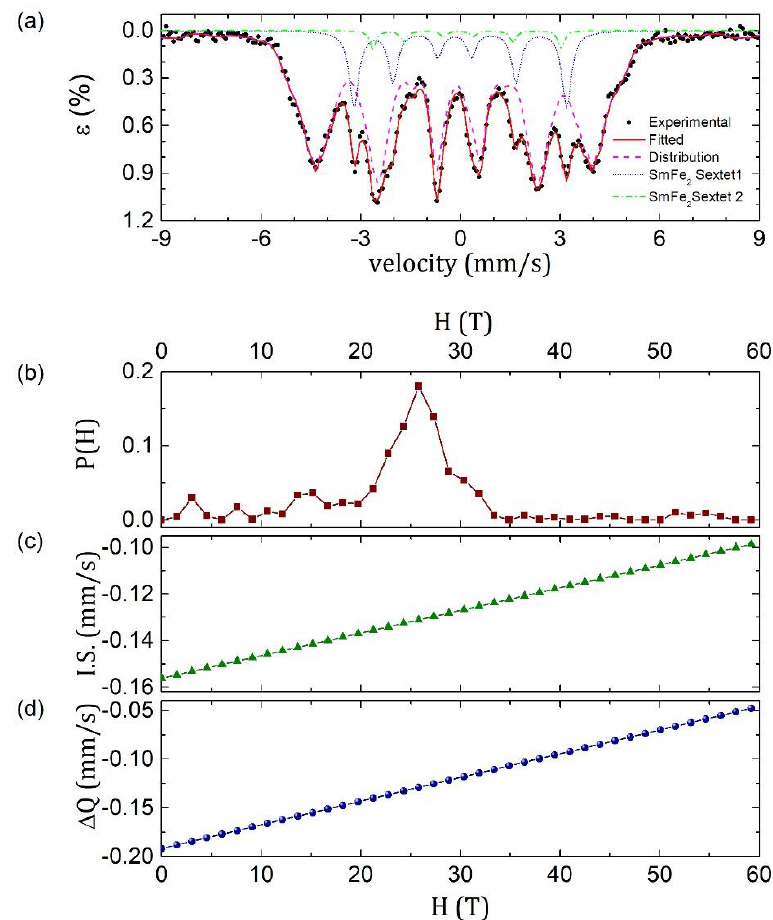
Figure 4. ( a ) Mössbauer spectrum collected and fitted to an amorphous phase and to SmFe 2 phase, ( b ) distribution function of effective magnetic fields for the amorphous phase, ( c ) isomer shift linear function for the amorphous phase, and ( d ) quadrupolar splitting linear function for the amorphous phase. Table 2. Hyperfine parameters of the SmFe 2